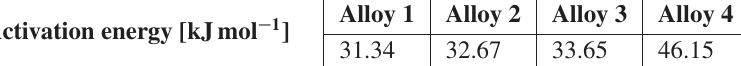
Table 2. Activation energies obtained from micro-hardness measurements.